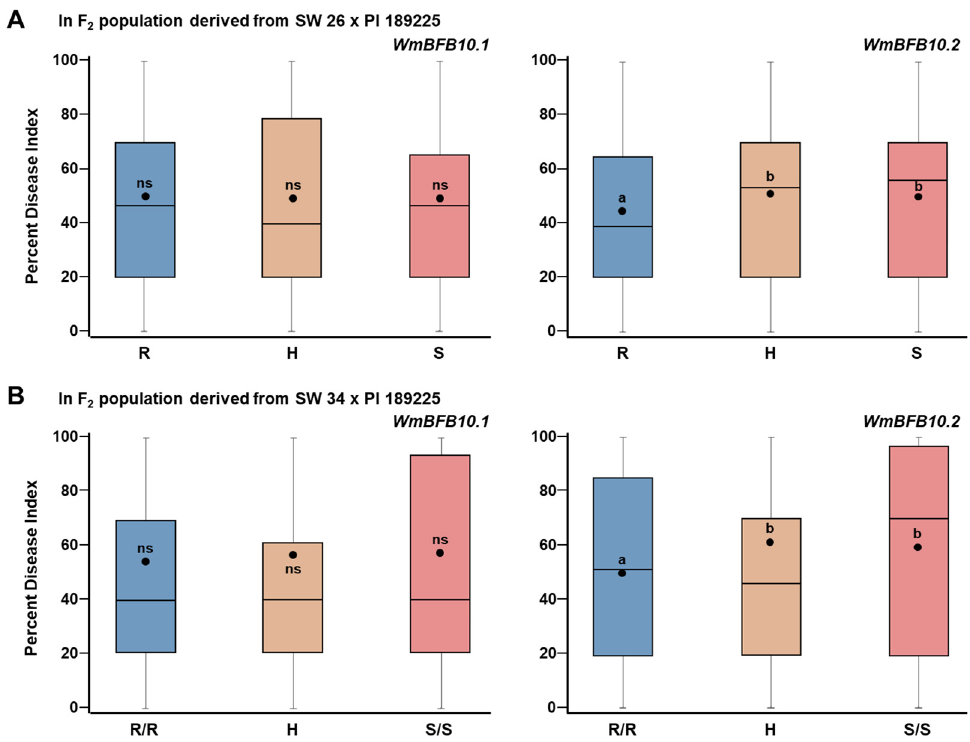
Figure 5. Box plots showing the differences in the percent disease index (PDI) of progenies of F 2 population homozygous for resistant (R/R, PI 189225) allele, for susceptibility (S/S, SW 26) allele and for the heterozygous (H) allele as determined by the HRM assays for the SNPs, Chr10_6133795 and Chr10_32259129 in ClBFB10.1 and ClBFB10.2 , respectively. ( A ) F 2 (SW 26 × PI 189225) ( n = 214) and ( B ) F 2 (SW 34 × PI 189225) ( n = 62) population. Dots in the boxes represent the mean. (ns, no significance; p < 0.05, significant at 95% levels of probability in one-way ANOVA).